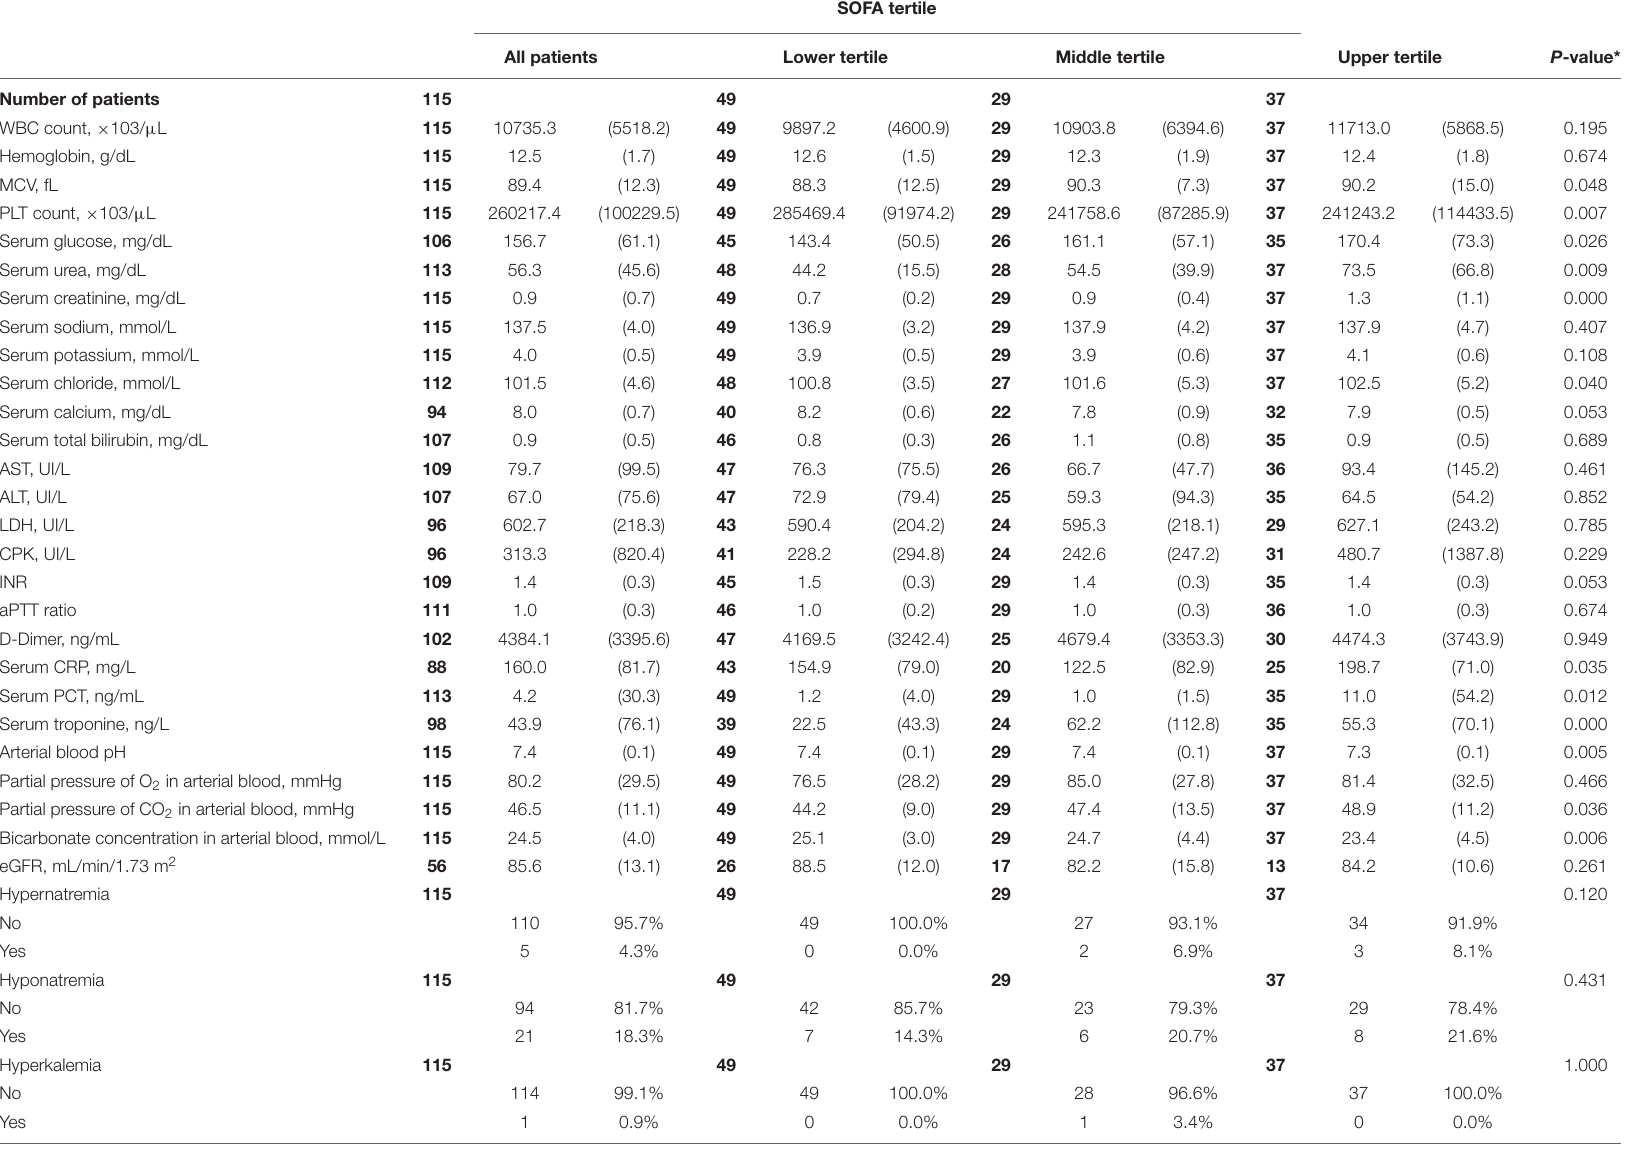
TABLE 2 | Laboratory data of patients according to tertiles of SOFA score at ICU